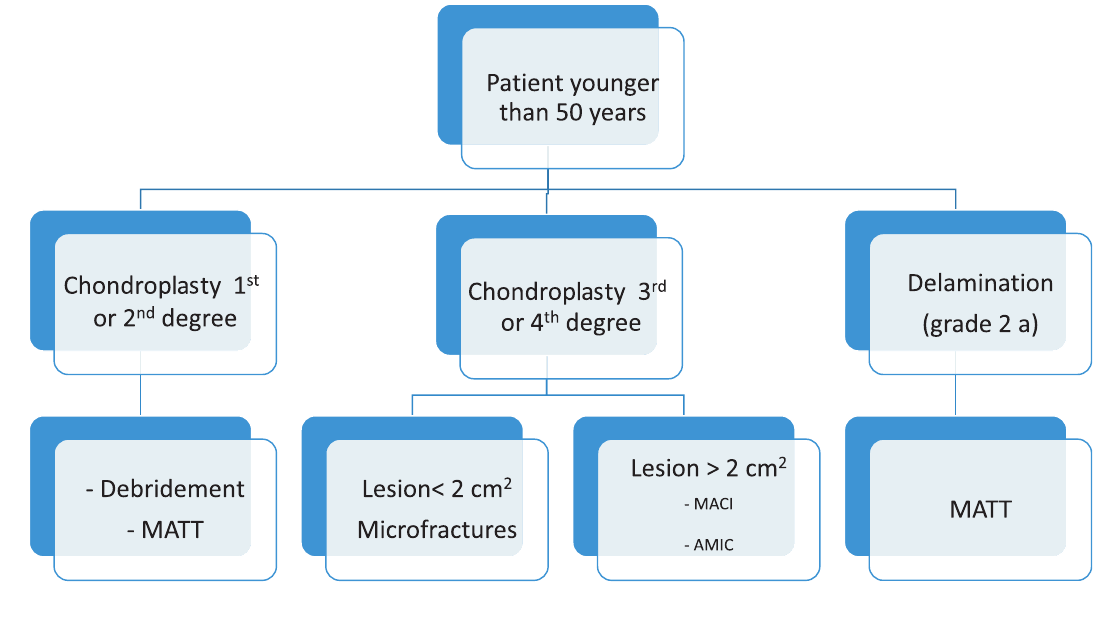
Table 1. Decision tree for patients younger than 50